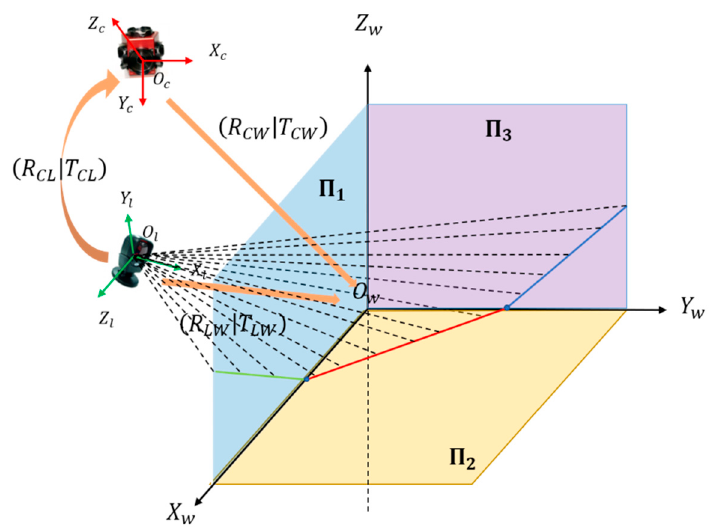
Figure 2. Configuration of the coordinate systems.